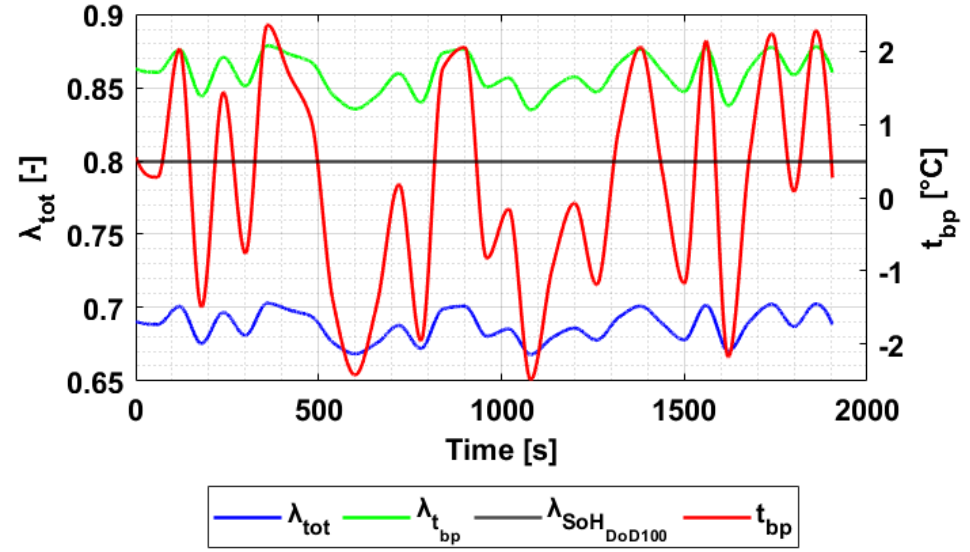
Figure 20. Combined effect of the battery pack temperature and the battery ageing level on λ tot for DM25 in the case of a battery with 300 life-cycles completed and DoD100.